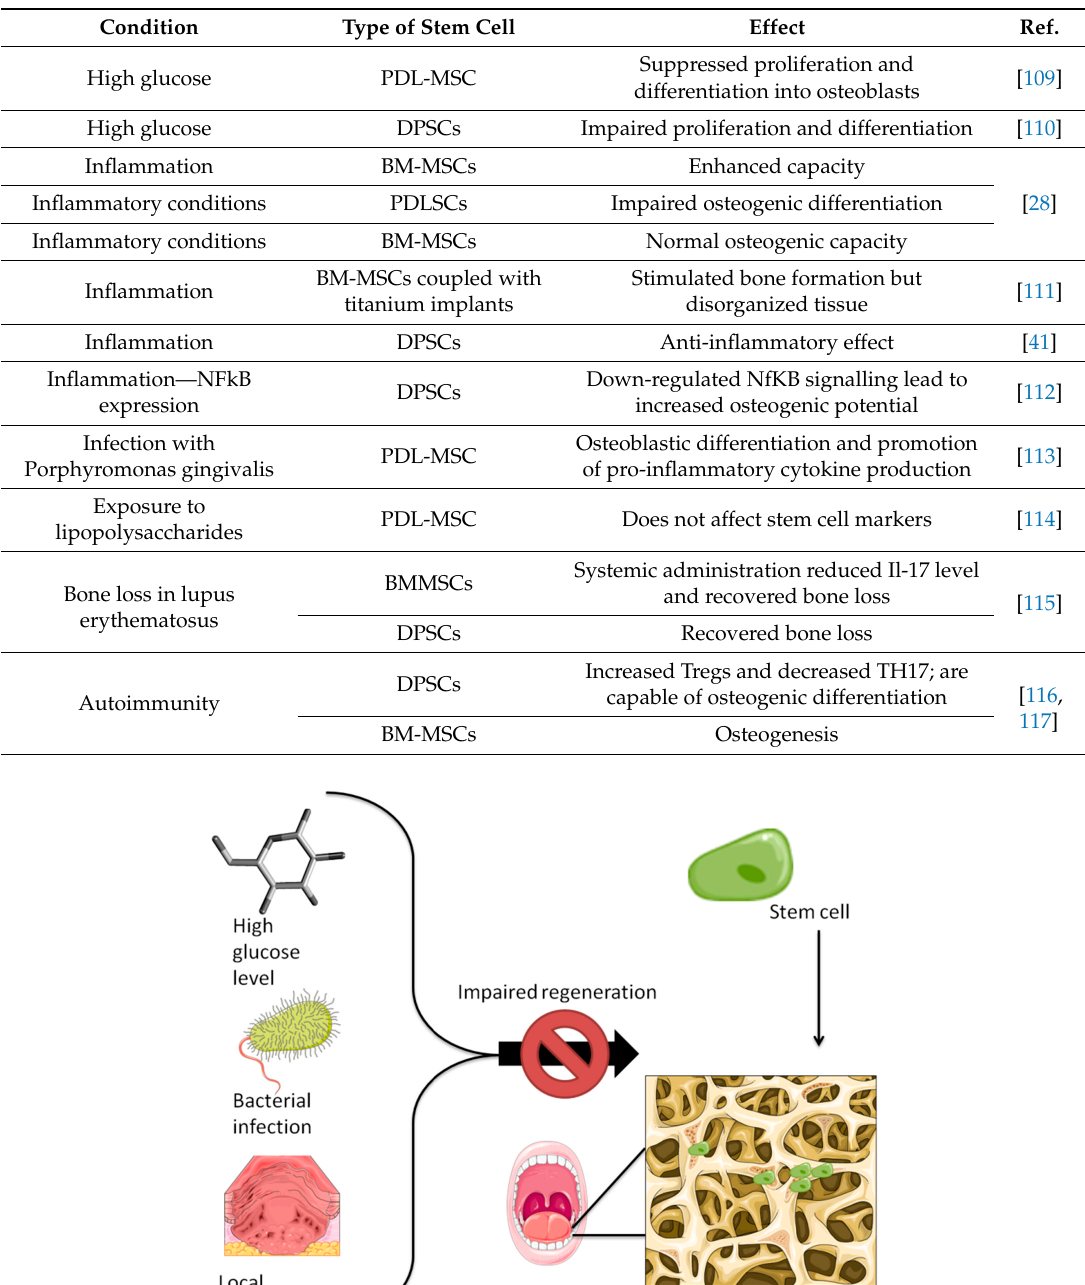
Table 2. The effect of pathological states on the capacity of bone regeneration of stem